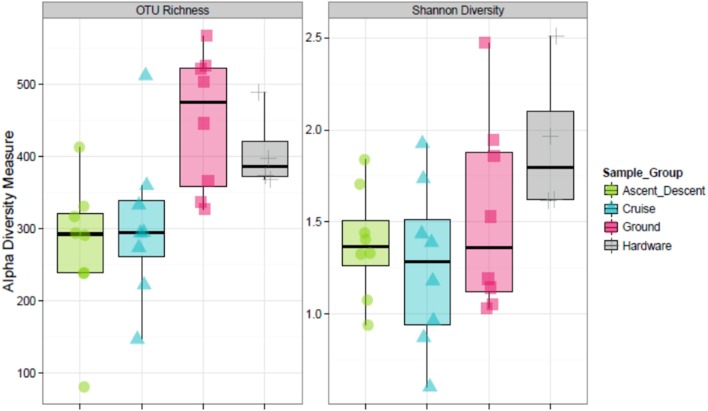
Alpha diversity estimates. (Left) OTU richness across sample groups. (Right) Shannon Diversity Index based on richness and evenness of OTUs within a sample.